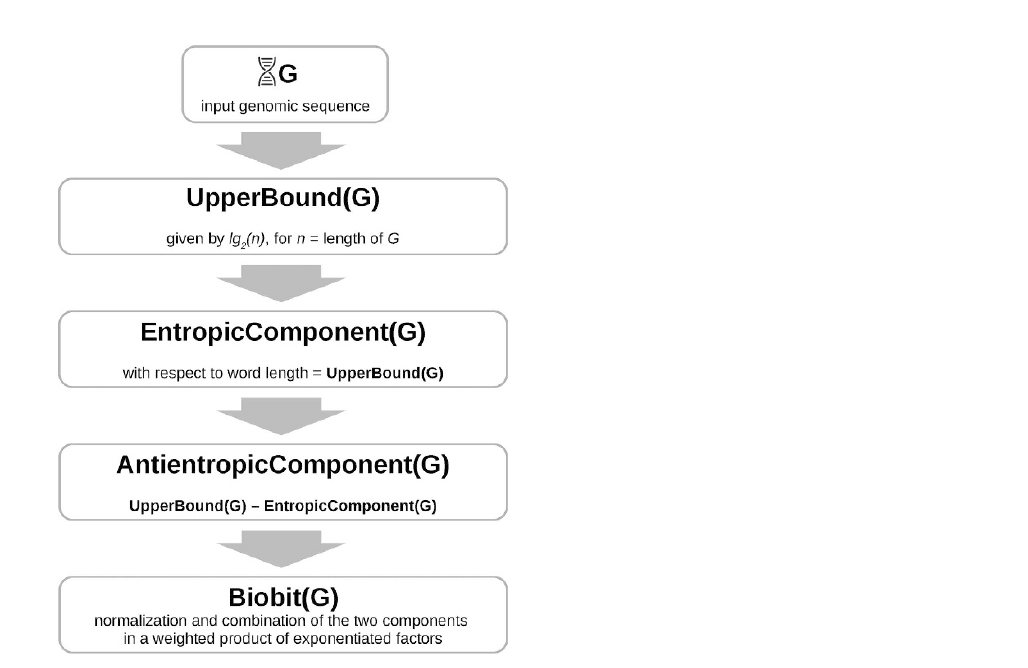
Figure 1. The left side of the figure shows the 70 analyzed genomes plotted on a Cartesian plane with their logarithmic length LG (G) as the abscissa and their biobit value BB (G) as the ordinate. An enlargement of the top-right region, which is highlighted with a dashed line, is shown on the right side of the image.